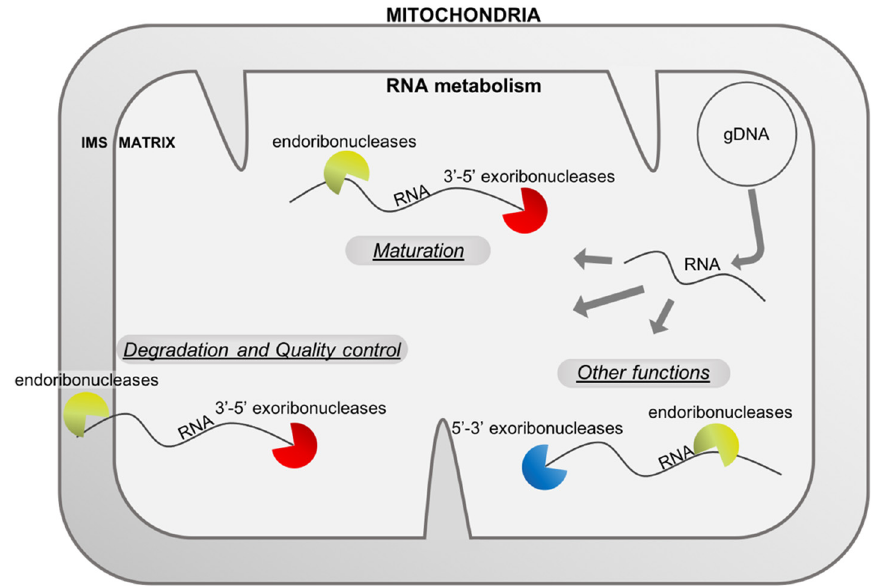
Figure 1. RNA metabolism in mitochondria uses different types of ribonucleases. The mitochondrial genome (here represented by a master circle at the top right) produces different types of RNAs (mRNA, rRNA, tRNA and asRNA, here stated RNA) that are matured or degraded by endo- and exo-ribonucleases. RNases are also implicated in other functions linked, for example, to the replication of the genome. All these RNases shape the final transcriptome of the mitochondria and are important for healthy mitochondria and organisms. IMS: intermembrane space, gDNA: genomic deoxyribonucleic acid, RNA: ribonucleic acid.